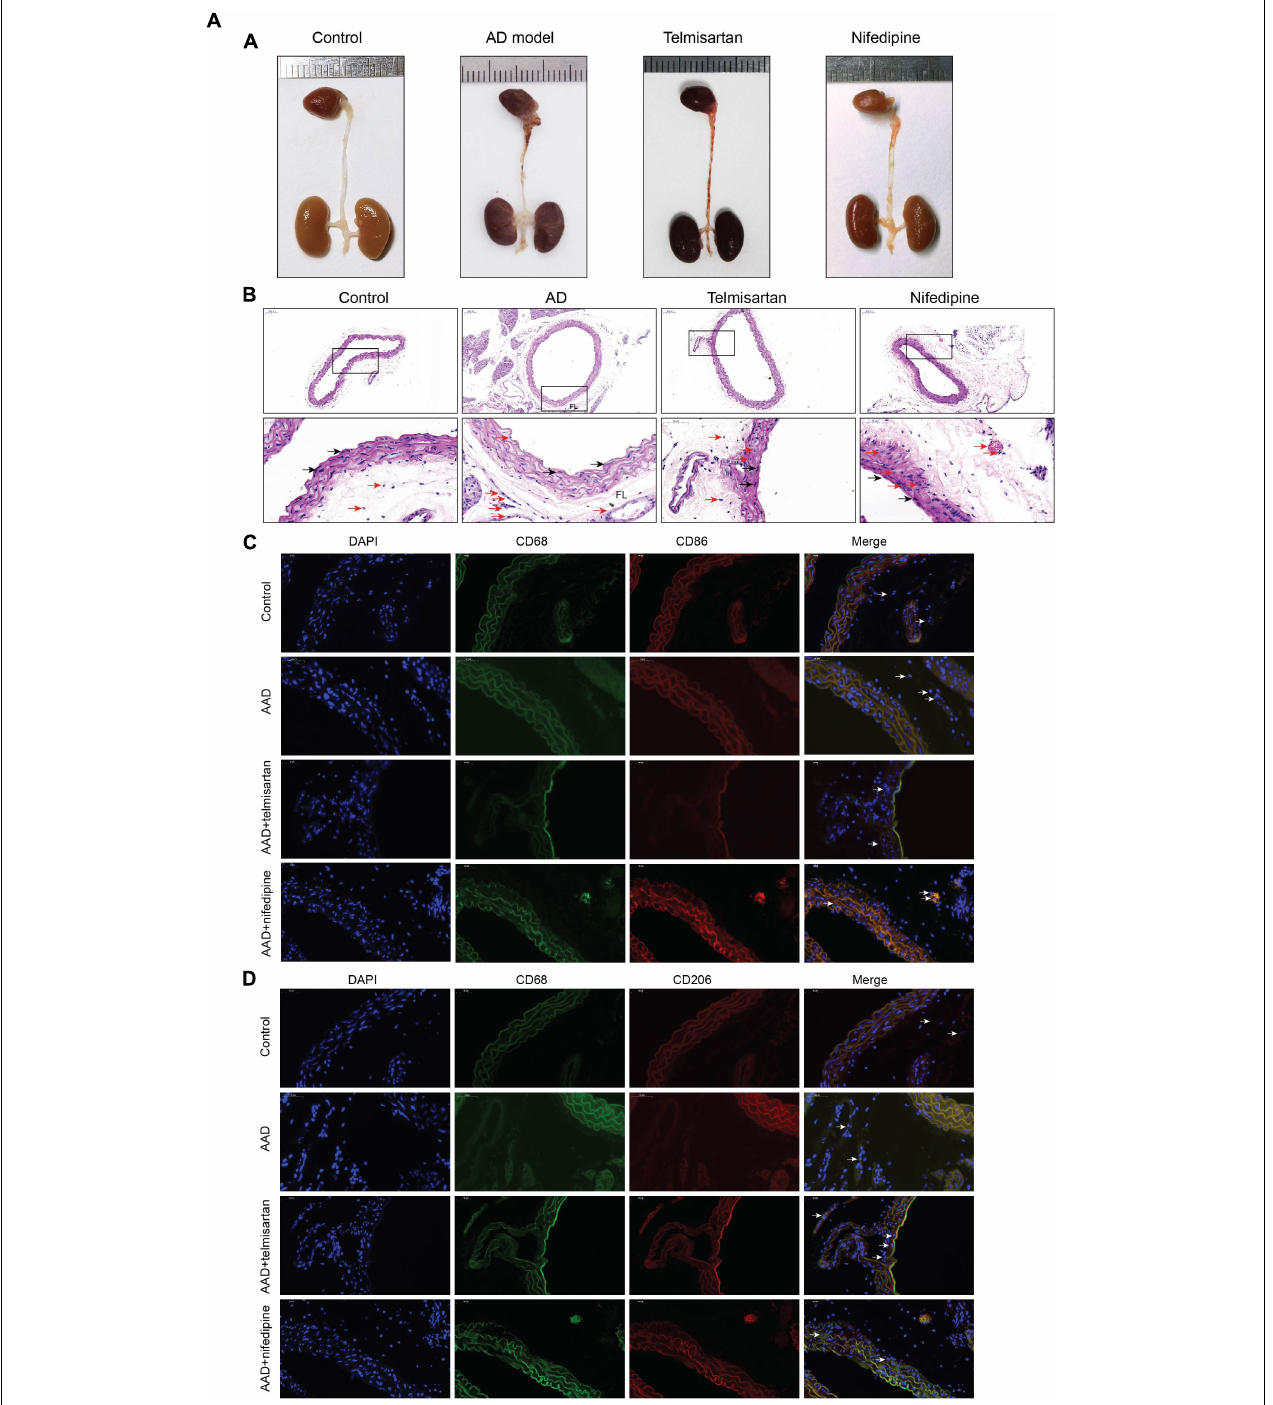
FIGURE 7A | M1 macrophages infiltrate in the torn aortic wall in AD mice, and telmisartan treatment can increase M2 infiltration in the aortic wall. (A) Different groups of mouse aortic samples were presented. (B) HE staining of aortic tissue sections in each group. The first row is a magnified image of 100 times, and the second row is a magnified image of 400 times. The black arrow indicates the endothelial cells, and the red arrow indicates the macrophages. (C) 400-fold magnification of M1 macrophages (CD68 + /CD86 +) tissue fluorescent staining images. White arrow indicates M1 macrophages. (D) 400-fold magnification of M2 macrophages (CD68 + /CD206 +) tissue fluorescent staining images. White arrow indicates M2 macrophages.